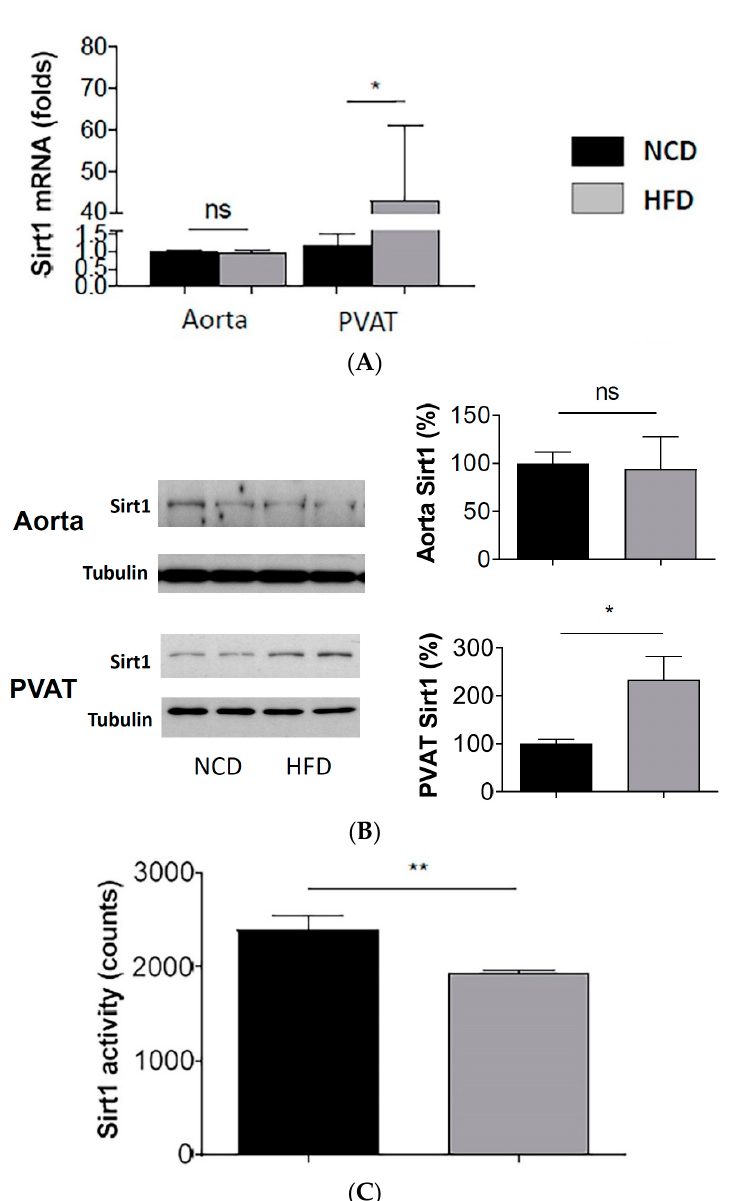
Figure 2. Reduced SIRT1 activity despite enhanced SIRT1 expression in PVAT of diet-induced obese mice. Male C57BL/6J mice were treated with normal control diet (NCD) or high-fat diet (HFD) for 20 weeks. The mRNA expression of SIRT1 ( A ) was studied with qPCR. The protein expression of SIRT1 ( B ) was studied with Western blot. The blots shown are representative for 3 independent experiments with similar results. * p < 0.05; ns, not significant; n = 10. SIRT1 activity ( C ) in mouse PVAT lysate was measured with SIRT1 deacetylase fluorometric assay kit. Columns represent mean ± SEM. ** p < 0.01; n = 10.